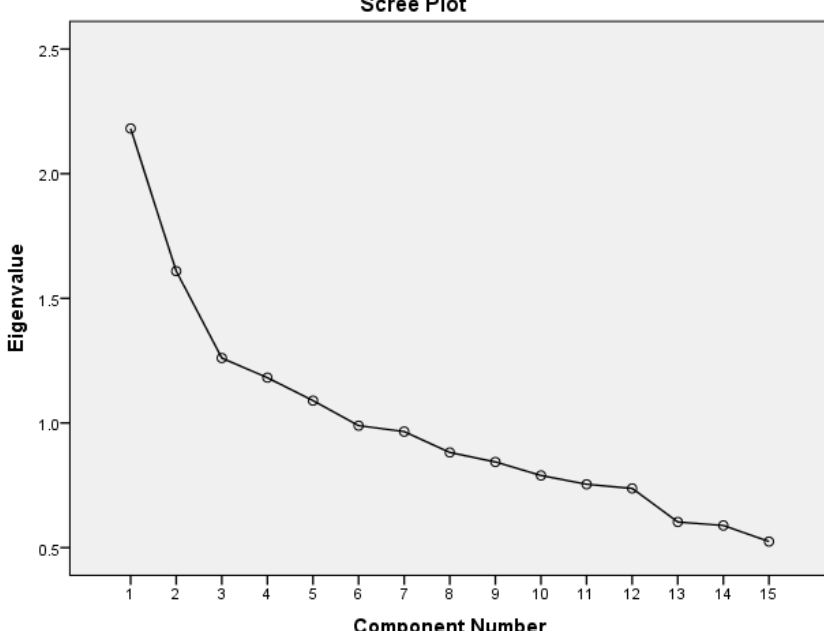
Figure 1. Scree plot showing eigenvalues for the 15 components, extracted in weighted factor analysis of lifestyle and dietary data of study participants ( n = 747).